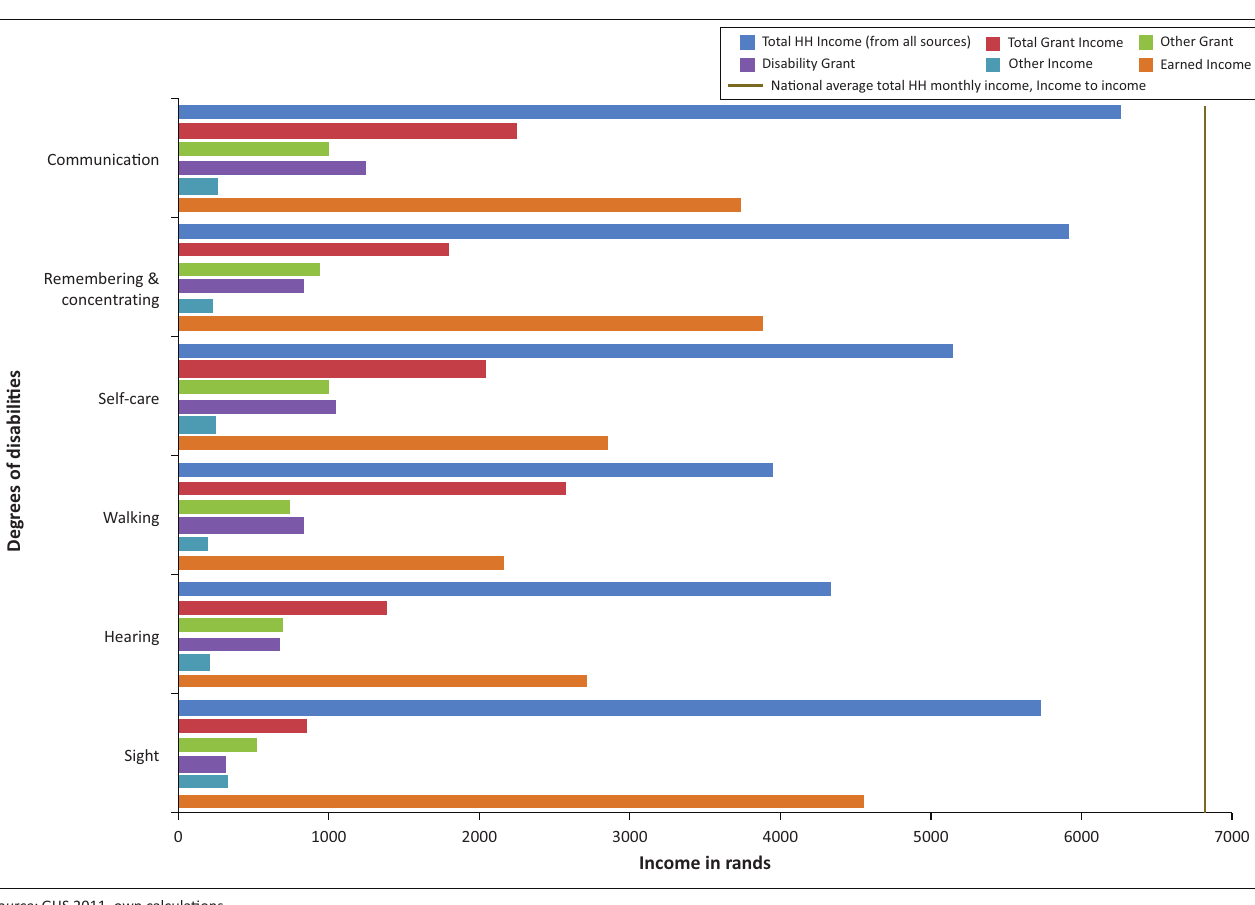
FIGURE 3: Average monthly household income, adults 15–59 years with severe disabilities, by